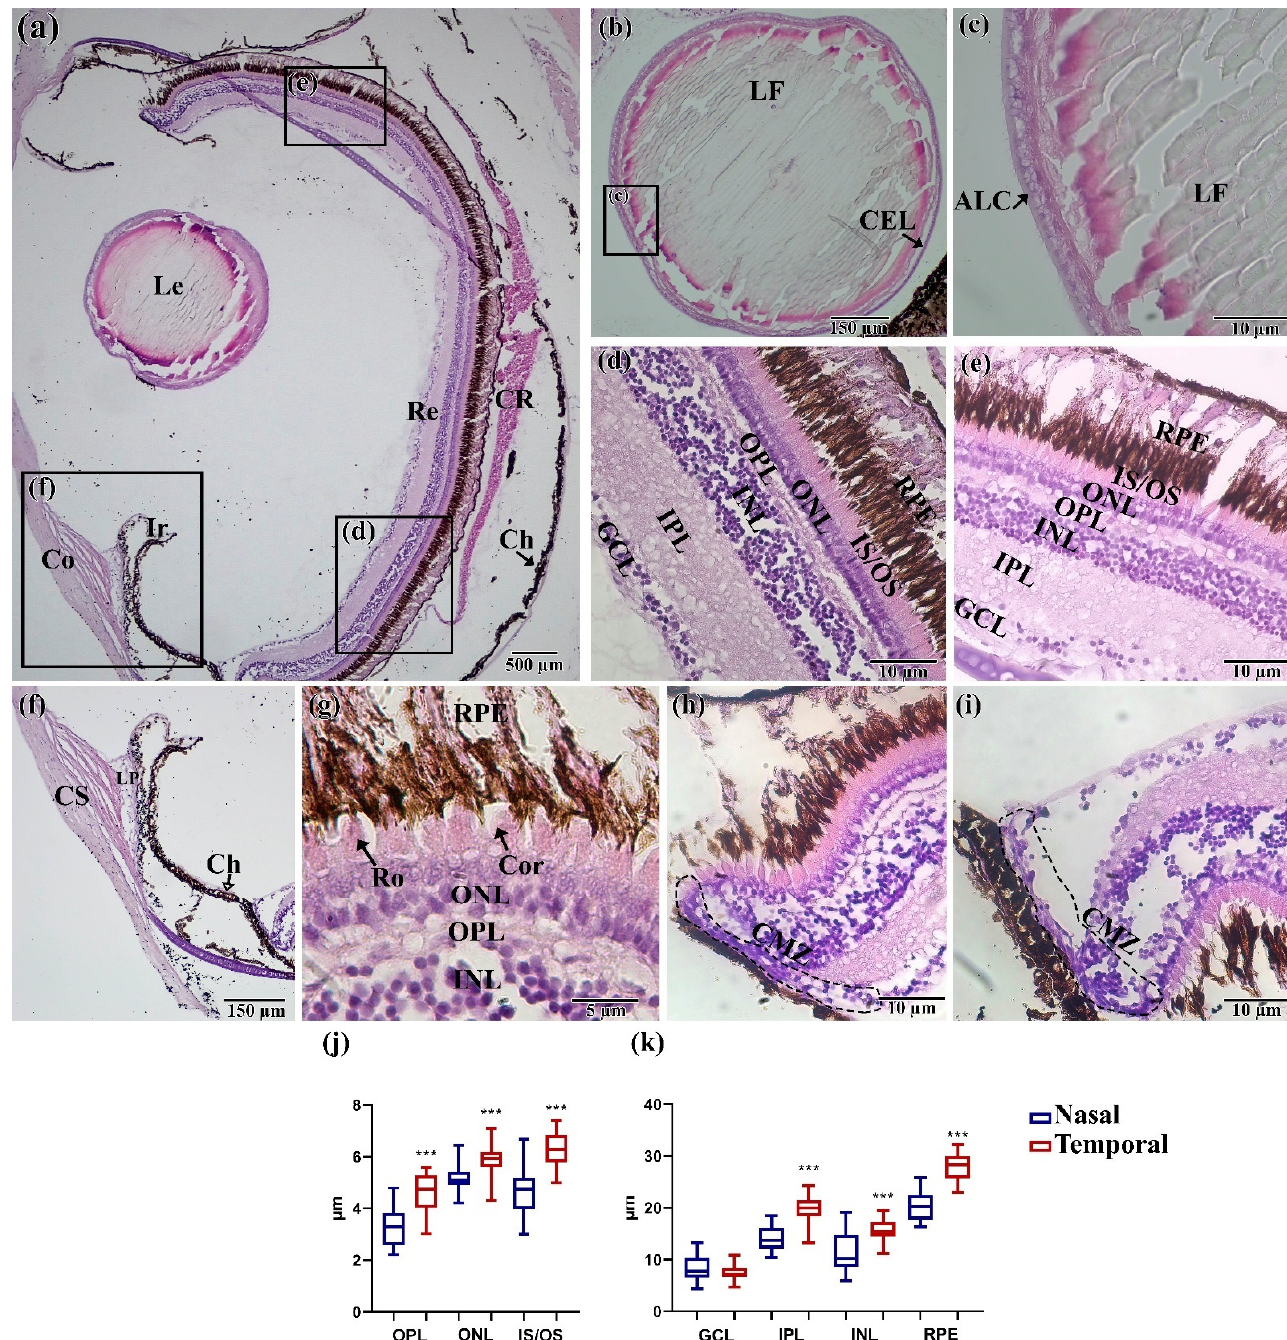
Figure 4. Histological structure of the eye of N. guentheri : ( a ) Total cut of the eye; ( b , c ) lens; ( d ) temporal part of the retina; ( e ) nasal part of the retina; ( f ) cornea and iris; ( g ) layer of receptor cell; ( h , i ) ciliary marginal zone; ( j , k ) thickness of layers in the temporal and nasal areas of the retina ( n = 3×50). The value (***— p < 0.001) from one-way ANOVA with comparison using Tukey’s post hoc analysis. Le—lens, Re—retina, Co—cornea, Ir—iris, CR—choroid rete, CS—corneal stroma, Ch—choroid, GCL—ganglion cell layer, IPL—inner plexiform layer, INL—inner nuclear layer, OPL—outer plexiform layer, ONL—outer nuclear layer, IS/OS—inner segment/outer segment of the photoreceptor cells, RPE—retinal pigment epithelium/cells, LF—lens fibers, ALC—acellular lens capsule, CEL—cuboidal epithelial lens cells; LP—ligamentum pectinatum; Ro—rods; Con—cones; CMZ—ciliary marginal zone. The N. guentheri retina has a clear-layered structure, including seven layers: gan- glion cell layer, inner plexiform layer, inner nuclear layer, outer plexiform layer,